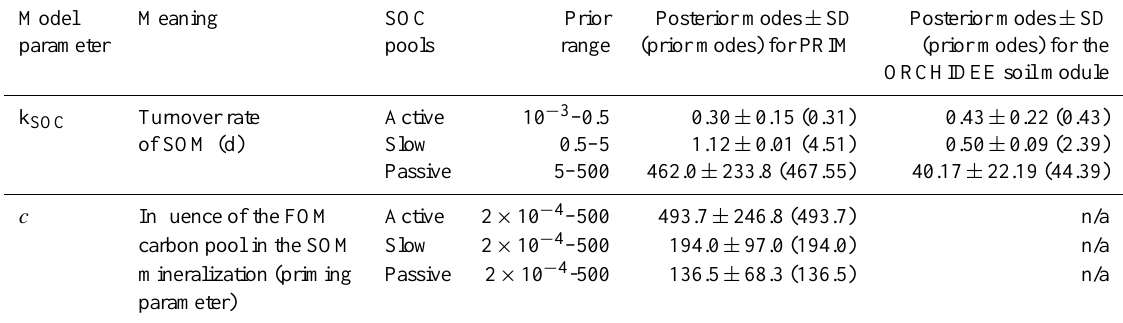
ORCHIDEE soil module